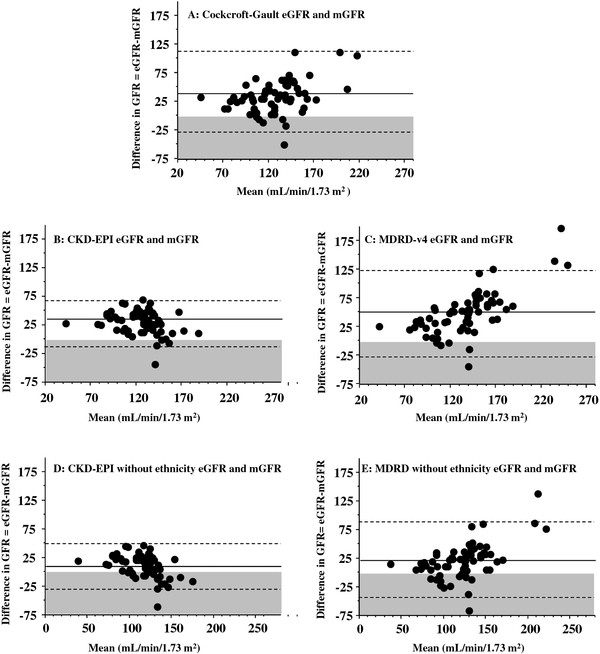
Bland and Altman plots for glomerular filtration rate (GFR) estimated with different equations compared to measured GFR. Each graph is a Bland and Altman plot comparing a specific equation used for GFR estimation to the reference method (GFR measured using iohexol plasma clearance). Mean GFR is calculated as follows: Mean GFR = (measured GFR + estimated GFR)/2. The plain line represents the mean difference between estimated GFR (eGFR) and GFR measured using the reference method (mGFR). In the grey zone, eGFR is lower than mGFR. Dashed lines represent ± 1.96 SD. Results are expressed as mL/min/1.73 m2.